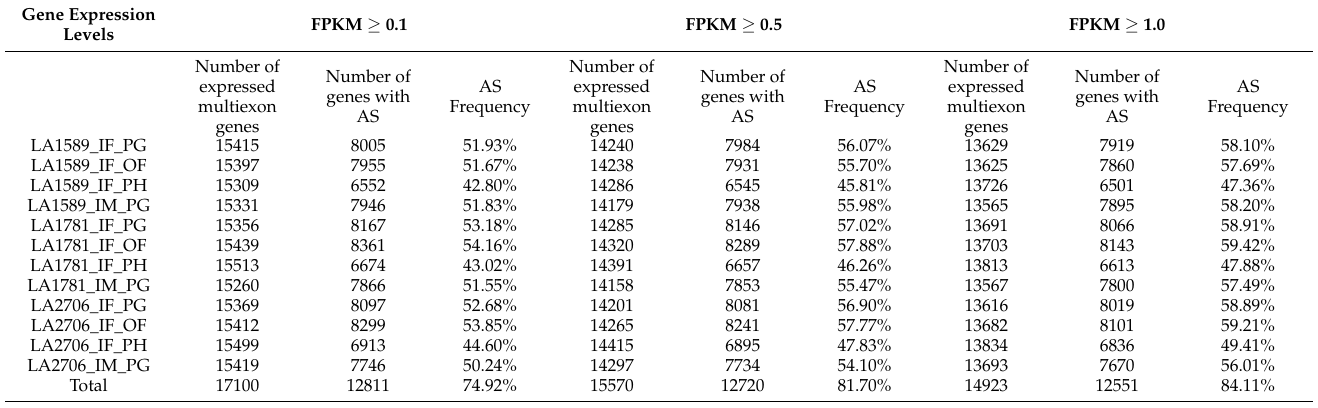
Table 1. The numbers of multiexon genes underwent AS in IM and IF from OF, PG and PH grown